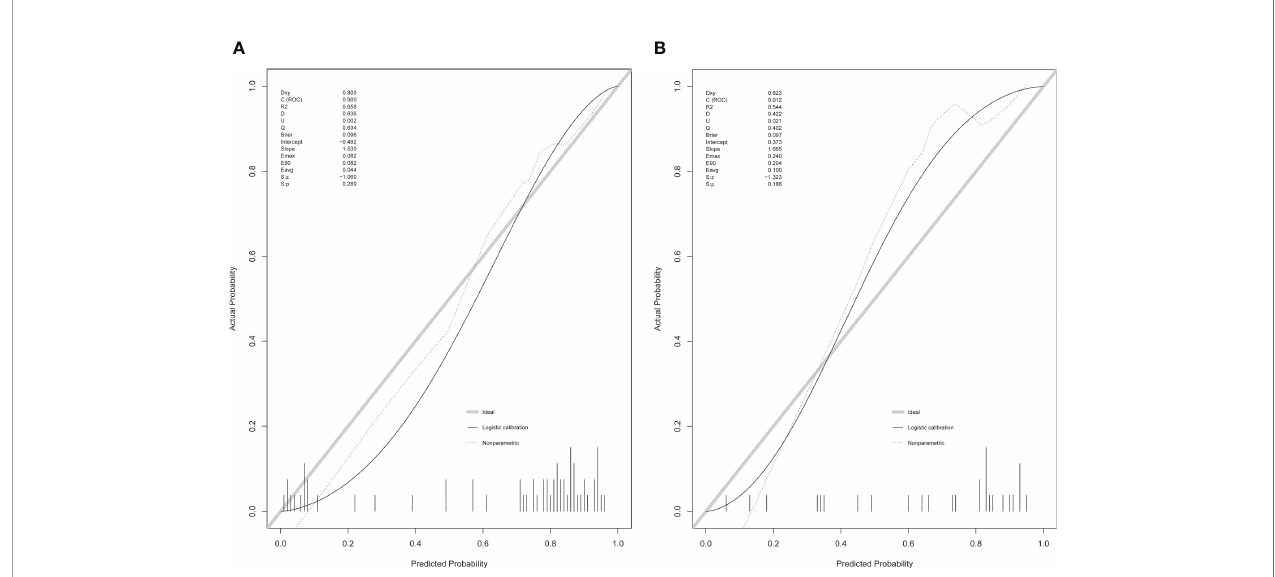
FIGURE 5 | Calibration curves of the clinical-radiomic nomogram in the training cohort (A) and validation cohort (B)